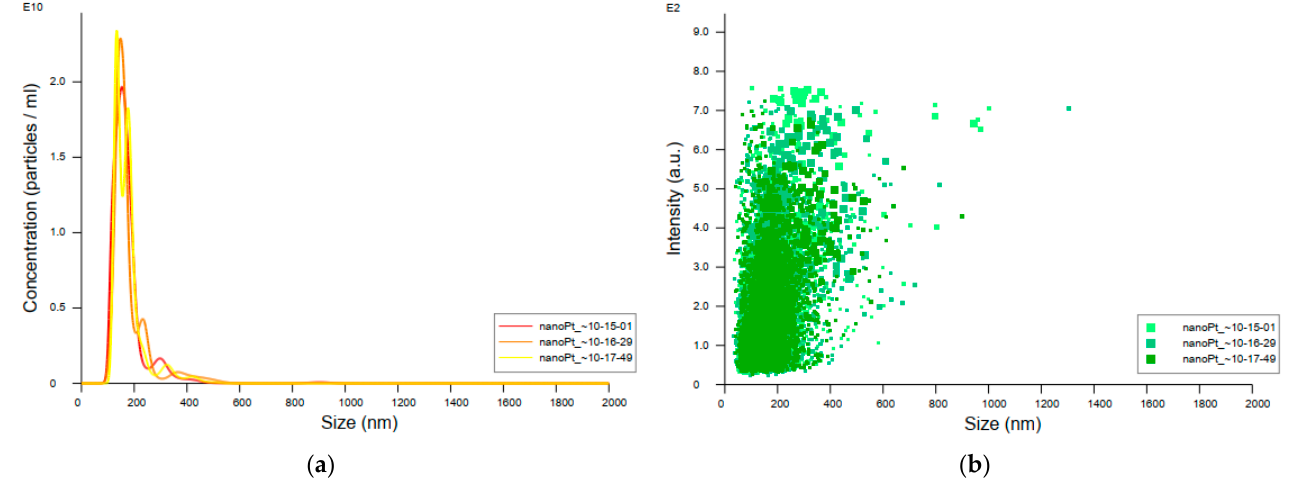
Figure 9. Nanoparticle Tracking Analyzer data obtained after analysis of original colloidal platinum nanoparticle samples: ( a ) distribution of particle sizes by concentration; ( b ) distribution of particle sizes by intensity ( n = 3).